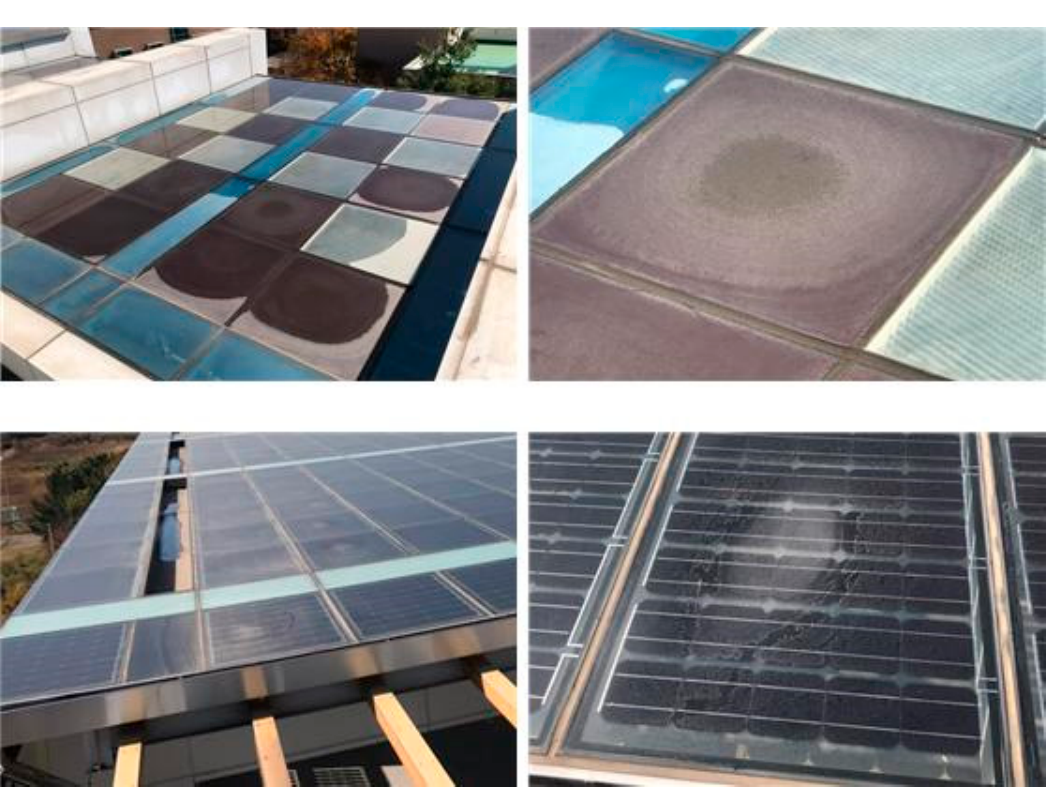
Figure 16. Dust accumulation on the front of the horizontal BIPV modules in the Carbon Zero Building (Top left, Inv-9; top right, Inv-9 details; bottom left, Inv-15; bottom right, Inv-15 details).